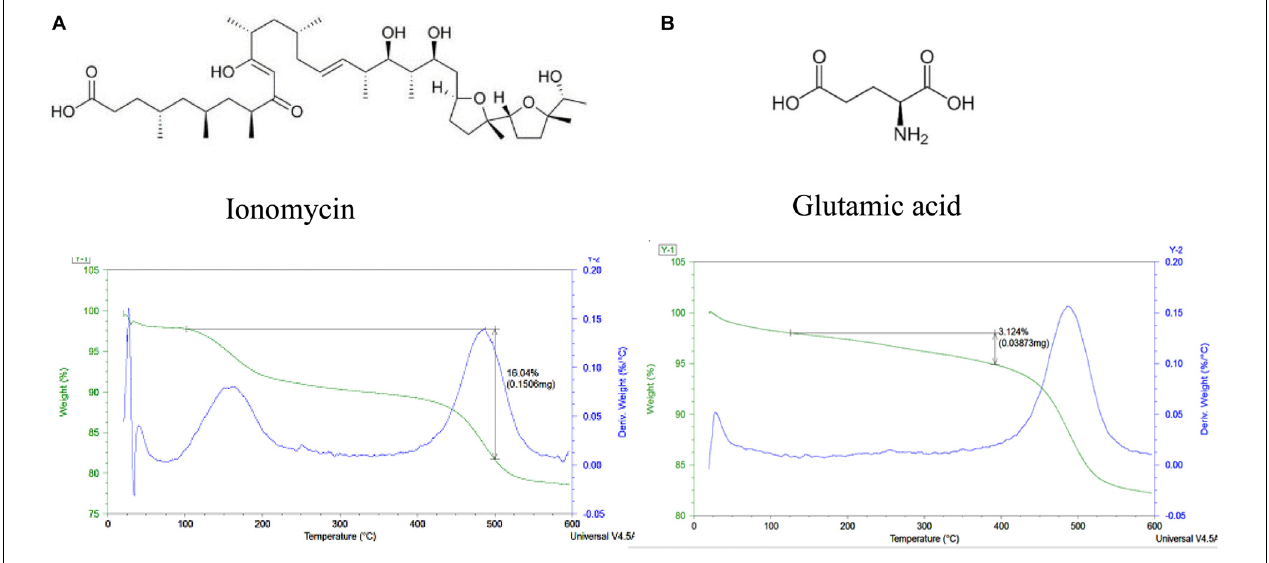
FIGURE 5 | Thermogravimetric data for halloysite loaded with ionomycin and glutamic acid (A,B) .